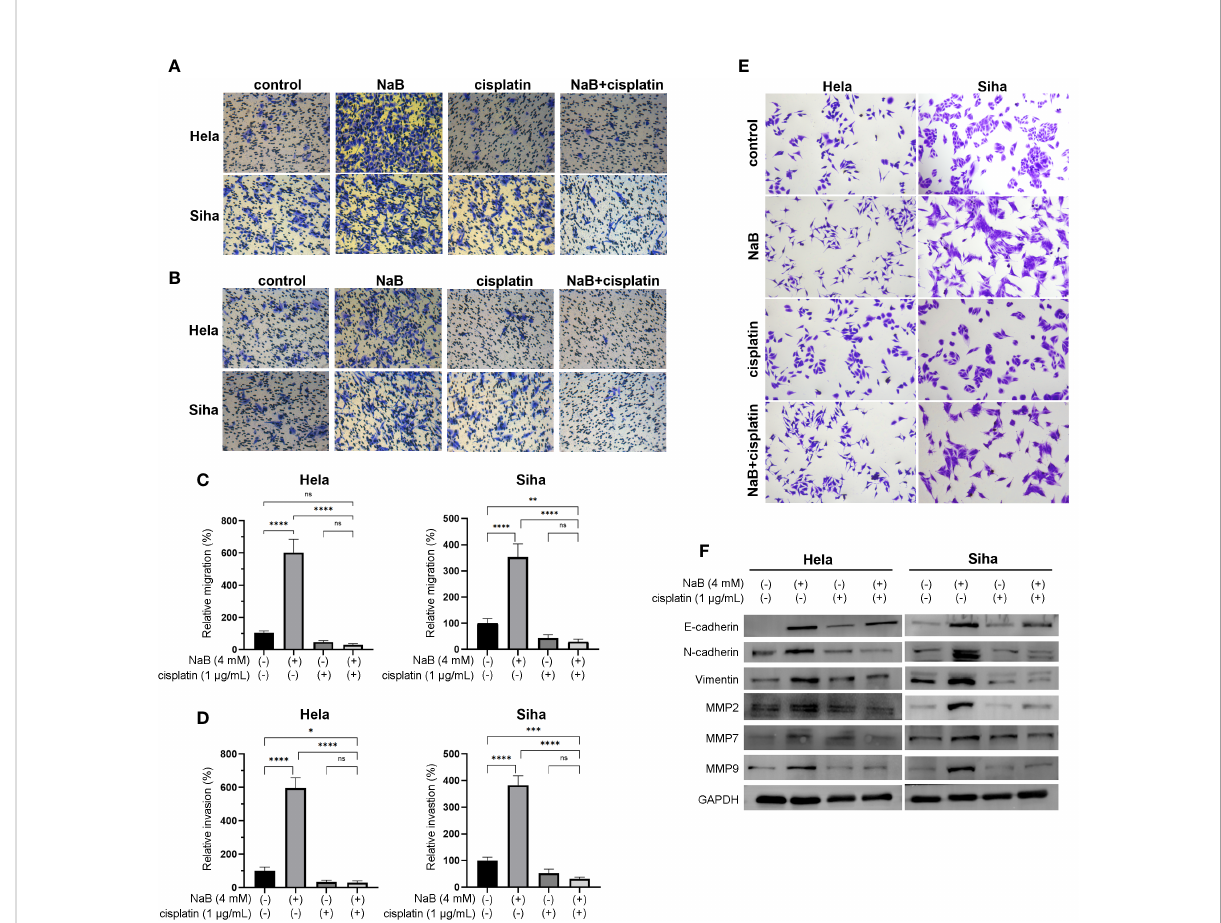
FIGURE 2 NaB combined with cisplatin inhibited the cell viability of Hela and Siha cells through promoting their apoptosis. (A) Migration and (B) invasion were detected by Transwell assays. (C) Migration and (D) invasion were quantitatively presented in the histogram. (E) Spindle-shaped morphological changes of Hela and Siha cells were observed after crystal violet staining. (F) Protein bands of E-cadherin, N-cadherin, vimentin, MMP2, MMP7, MMP9, and GAPDH (internal control) were visualized by Western blot. Hela and Siha cells were treated with NaB (4 mM) alone or in combination with cisplatin (1 m g/mL). Data represent the mean + standard deviation from 3 independent experiments. Signi fi cance was examined by one-way ANNOVA ( ns P > 0.05, *P < 0.05, **P <0.01, ***P < 0.001, ****P < 0.0001). NaB, sodium butyrate. Magni fi cation: 200